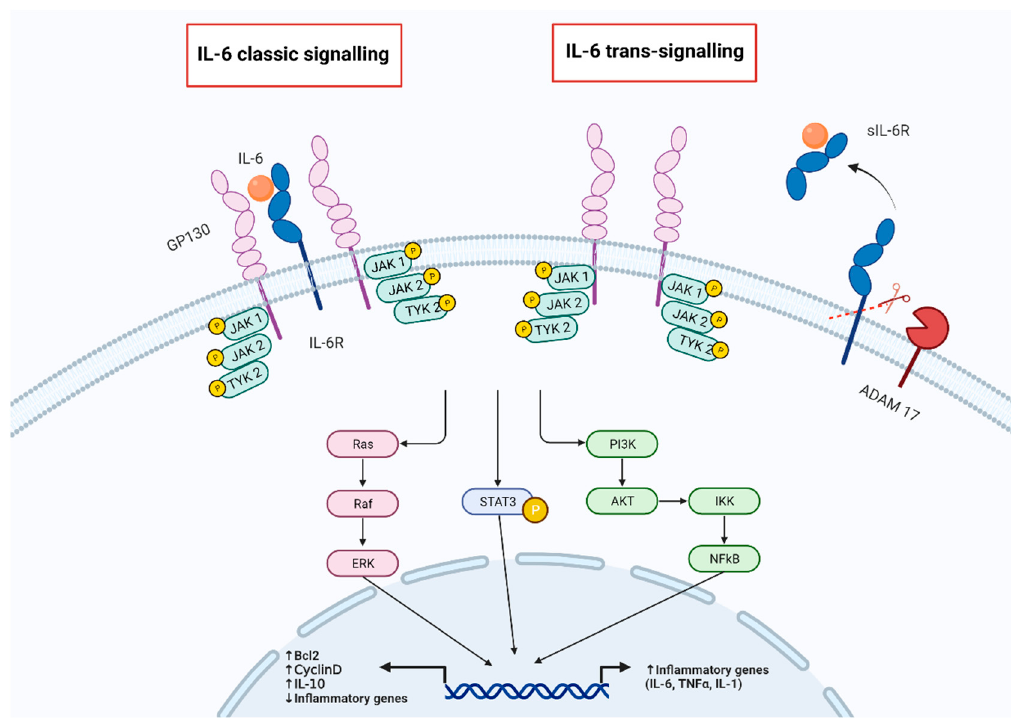
Figure 1. IL-6 pathways.